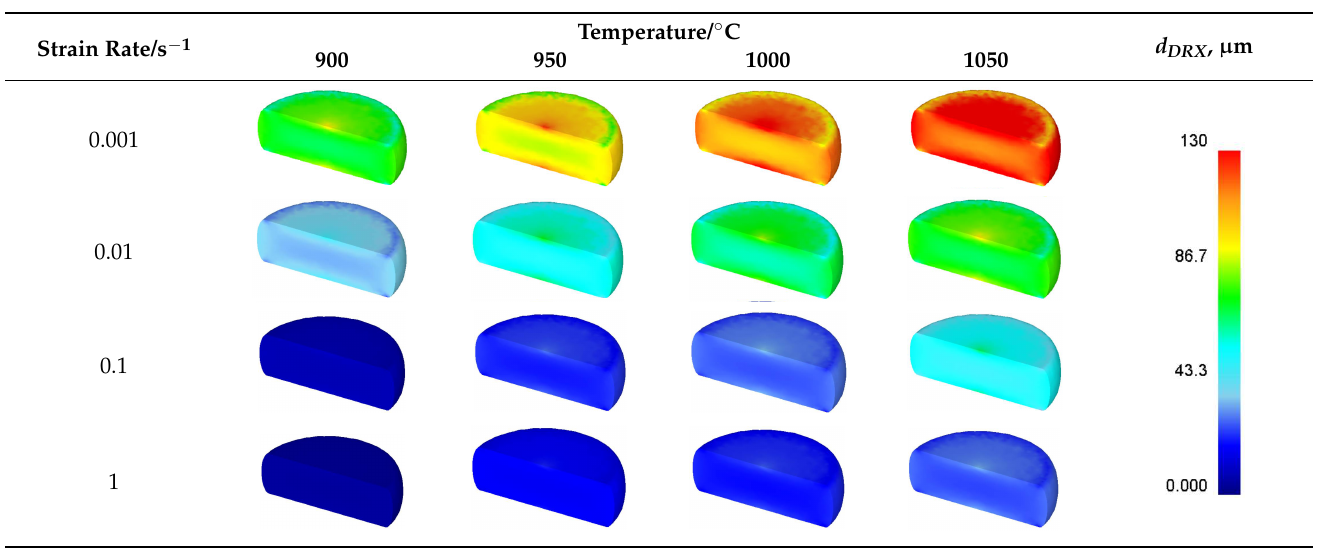
Table 3. The distribution of X DRX for 47Zr-45Ti-5Al-3V alloys deformed under various hot-working conditions at the true strain of 0.7.